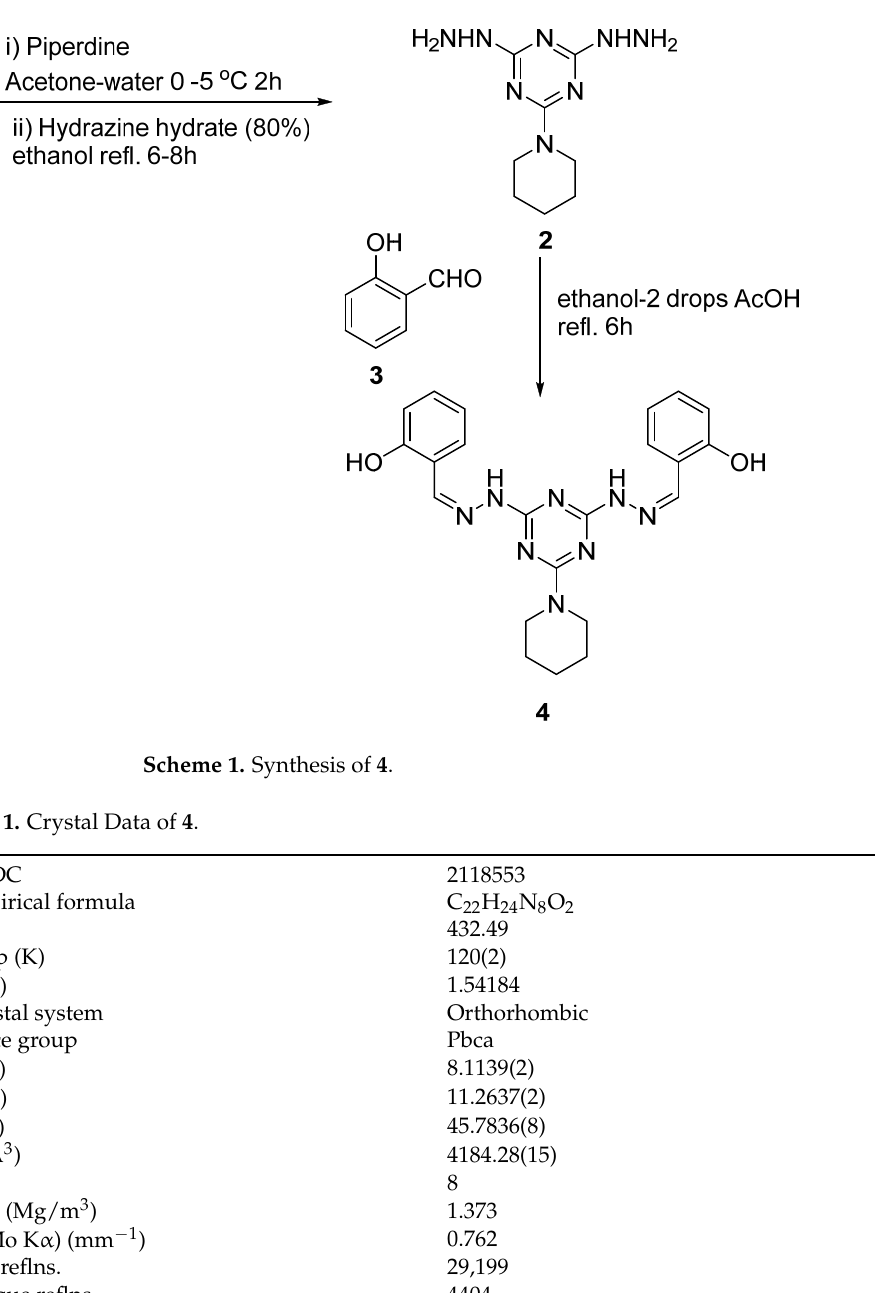
Table 1. Crystal Data of 4 .